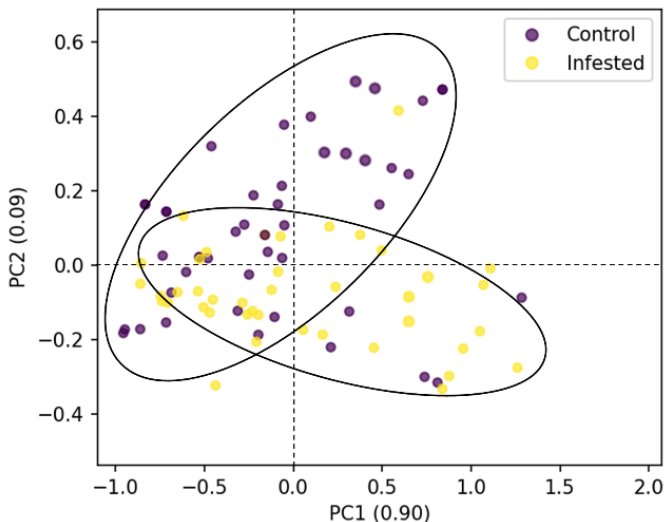
Figure 4. Principal component analysis of two types of apple sample tissues for Fuji cultivar computed from the mean spectral of the whole fruit.